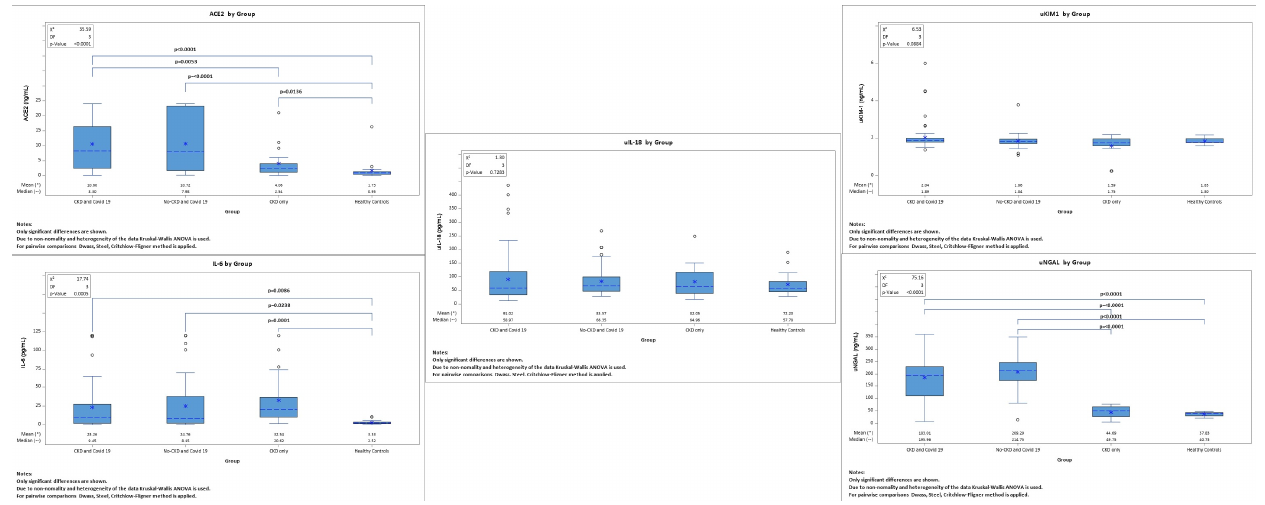
Figure 1. Comparisons between biomarkers across the four different groups.